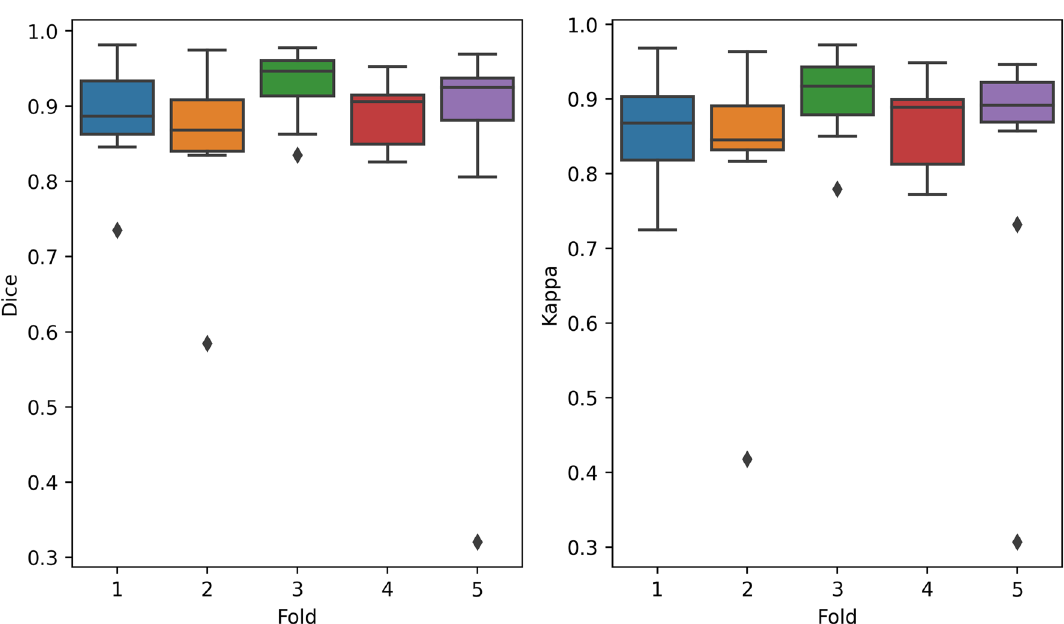
Figure 3. Distribution of the Dice and kappa scores in fivefold cross validation. The line within the box corresponds to median value, the range of each box to Q1-Q3 range (25–75% of scores) and whiskers to lowest and highest observations excluding outliers (individual